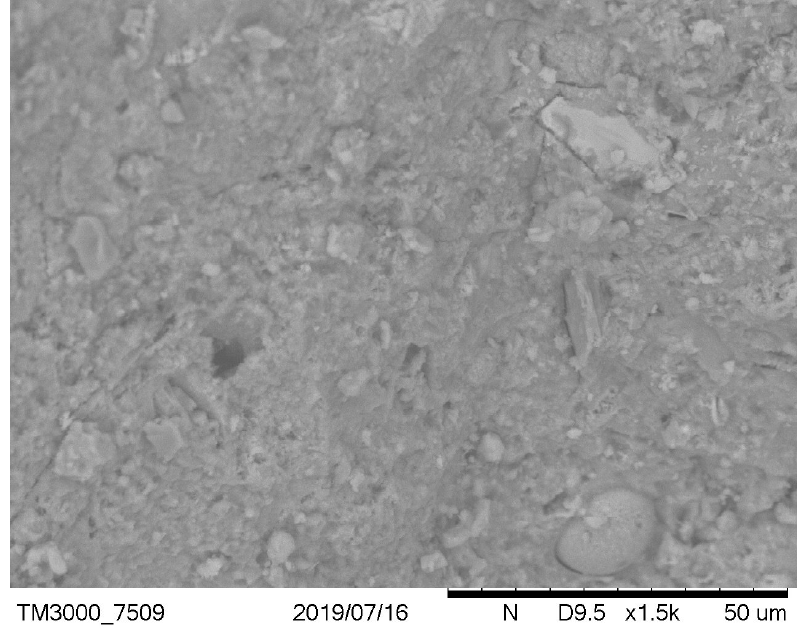
Figure 3. Noncarbonated concrete microstructure—mix symbol: 8, w / c = 0.38, p / c = 0.46.